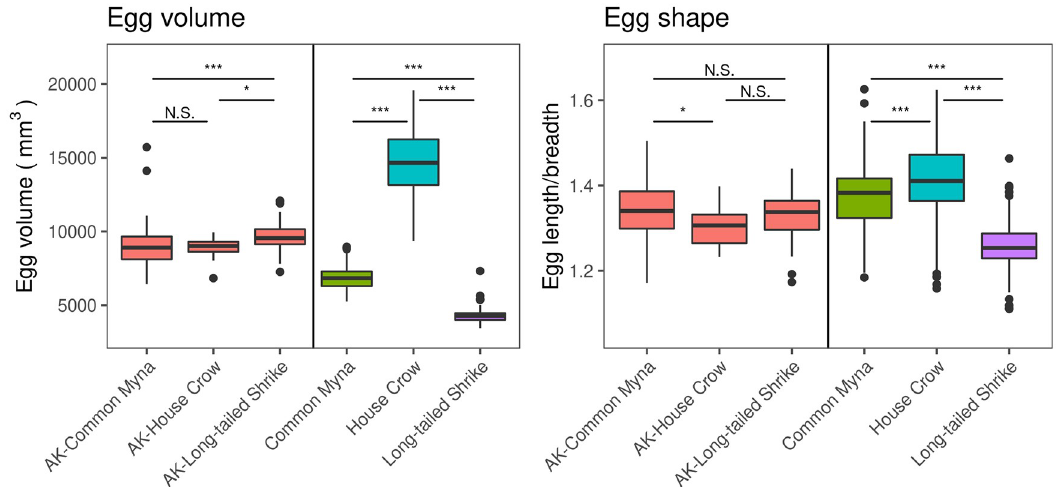
Fig 2. Egg volume and shape of Asian koel (AK) eggs laid in specific host nests (left panels) and eggs of host species (right panel). Asterisks denotes significant difference among Asian koel eggs and host eggs (see Table 1; N.S. p > 0.05, � p < 0.05, �� p < 0.01, ��� p < 0.001). Host and Asian koel eggs were analyzed separately. Vertical bars depict the 95% confidence